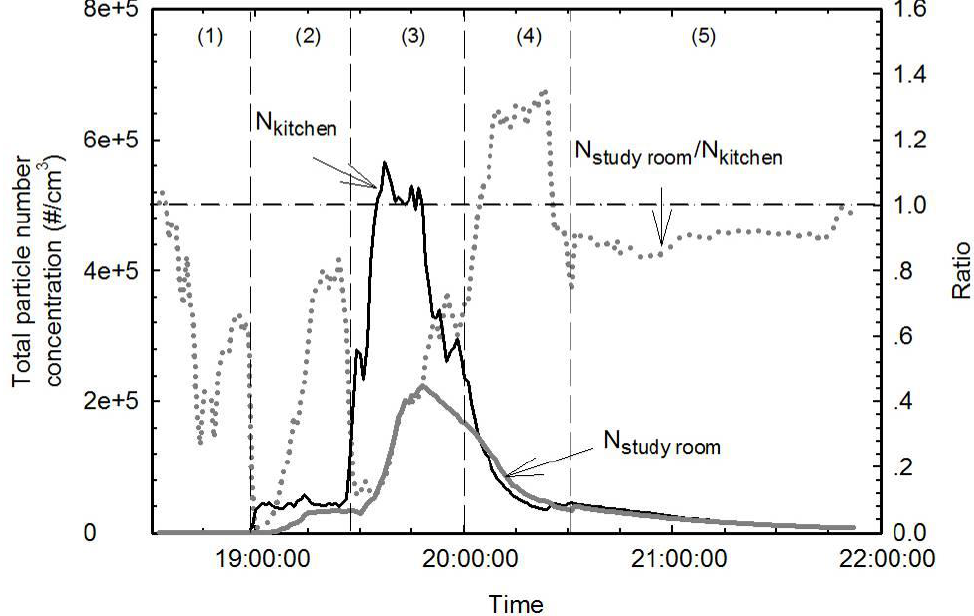
Figure 5. Time series of total particle number concentration emitted while cooking on an electric stove at high temperature with the exhaust fan turned on. Concentrations are shown for both the kitchen and the study room. The gray dotted line indicates the ratio of the total particle number concentration in the kitchen to that in the study